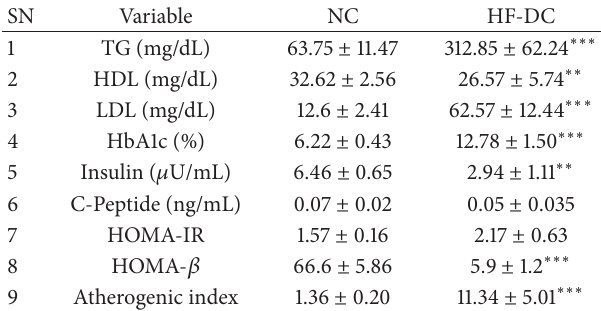
Table 2: Metabolic parameters in the experimental groups.